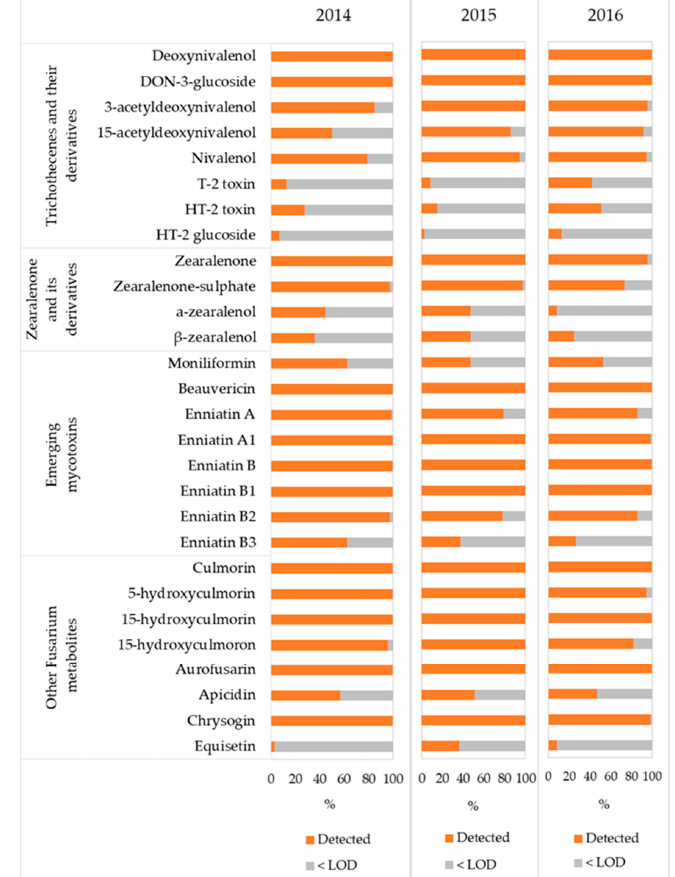
Figure 3. Percentage of detected mycotoxins by class in 72 analysed wheat samples (36 genotypes x 2 replicates) in 2014, 2015 and 2016 growing seasons. The Microsoft Excel Spreadsheet Software was used to create figure.